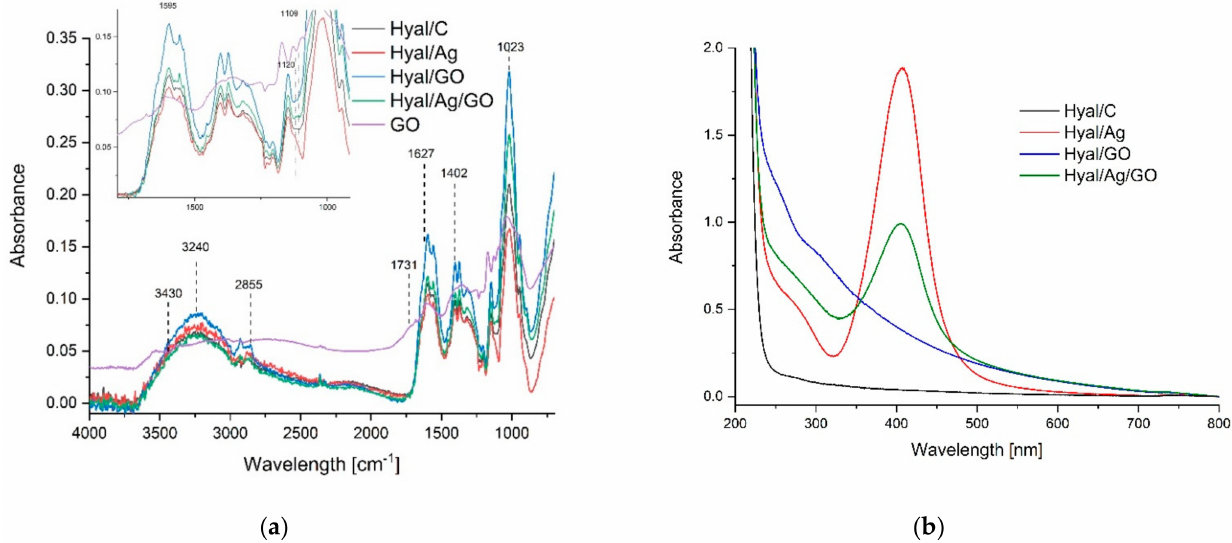
Figure 3. ( a ) FTIR spectra of Hyal/C (black line), Hyal/Ag (red line), Hyal/GO (blue line) and Hyal/Ag/GO (green line); ( b ) UV-vis spectra of Hyal/C (black line), Hyal/Ag (red line), Hyal/GO (blue line), Hyal/Ag/GO (green line) and GO (pink